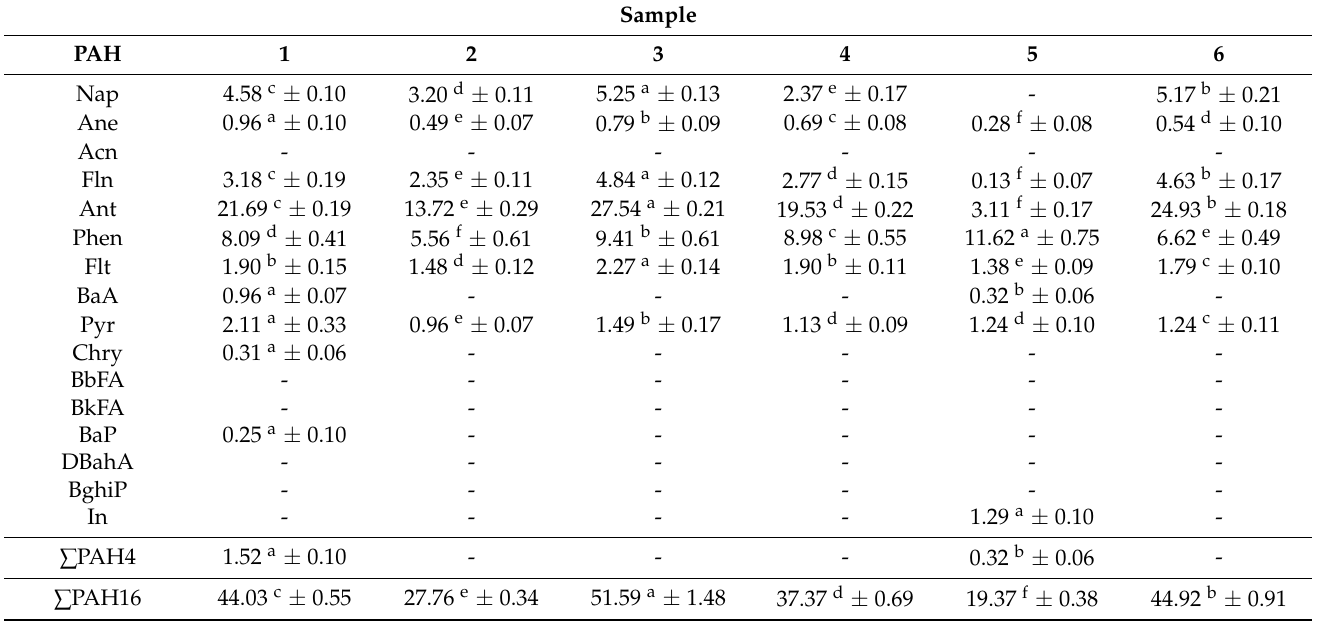
Table 3. PAH content ( µ g/kg) in different popcorn varieties in year 2019.